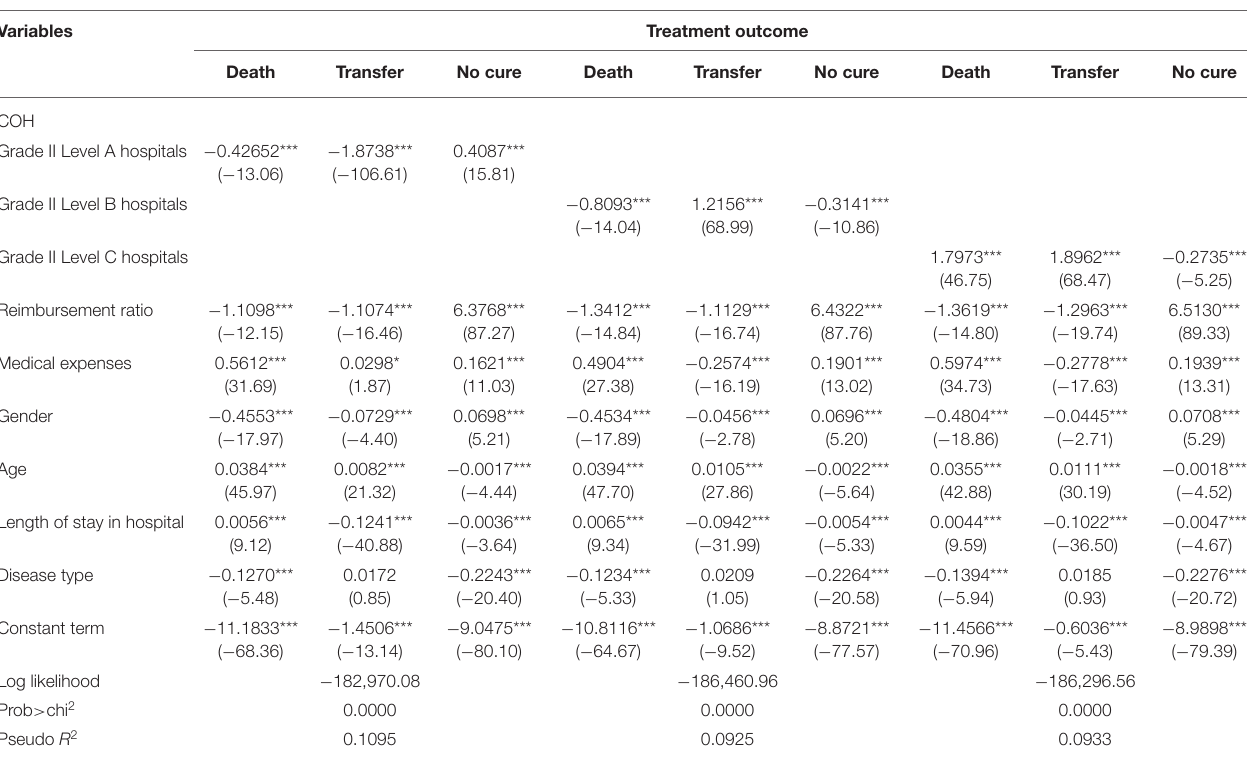
TABLE 5 | The NMNL model empirical results [by classification of hospital